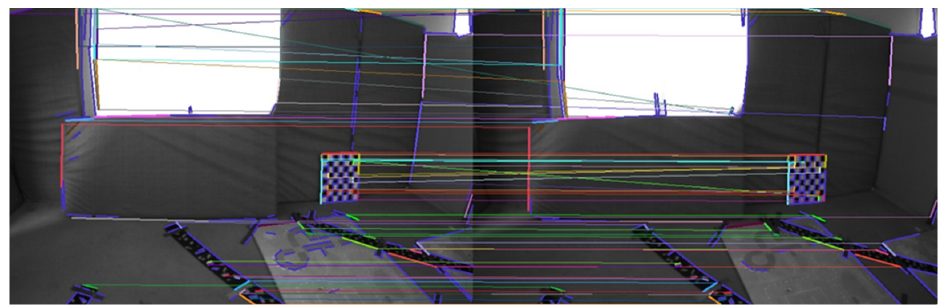
Figure 8. Results of feature line extraction and matching. There are darker image frames with insufficient lighting in the MH_05_difficult se- quence. The feature points and feature lines of the two sequences of images, respectively, were extracted and matched. The results are shown in Figures 9 and 10.